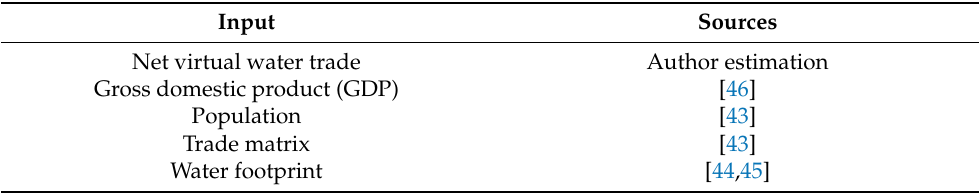
Table 3. Overview of data